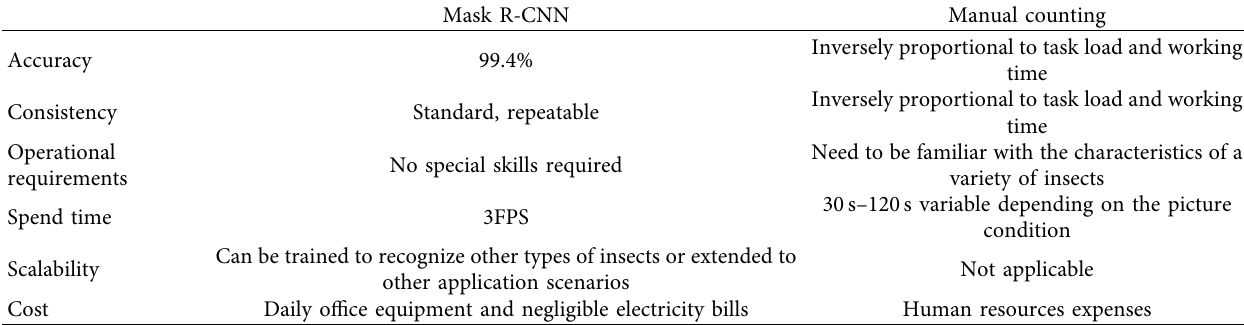
Table 5: Mask R-CNN and manual counting metric